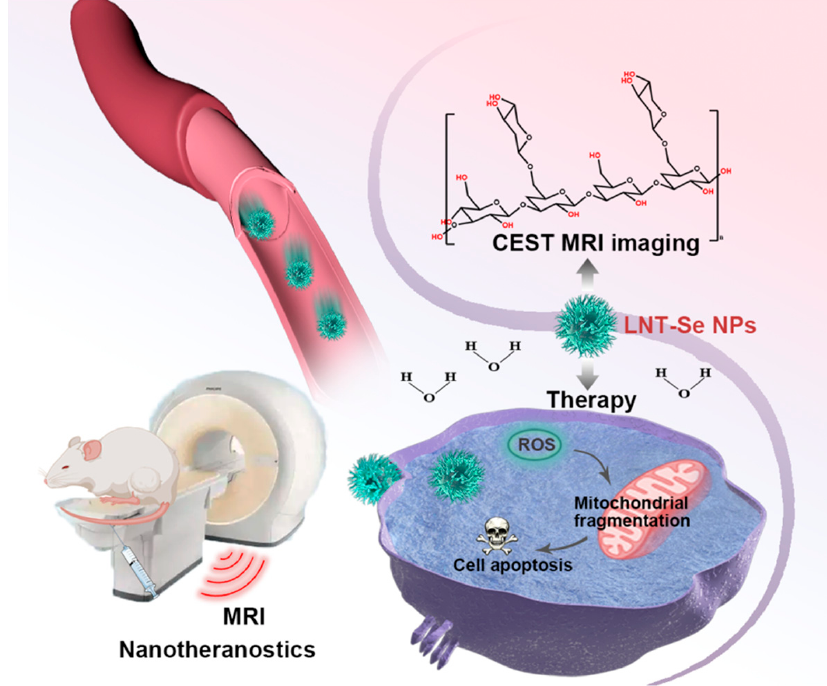
Figure 1. The rational design of theranostic cancer treatment using lentinan-coated selenium nanoparticles and label-free CEST MRI.